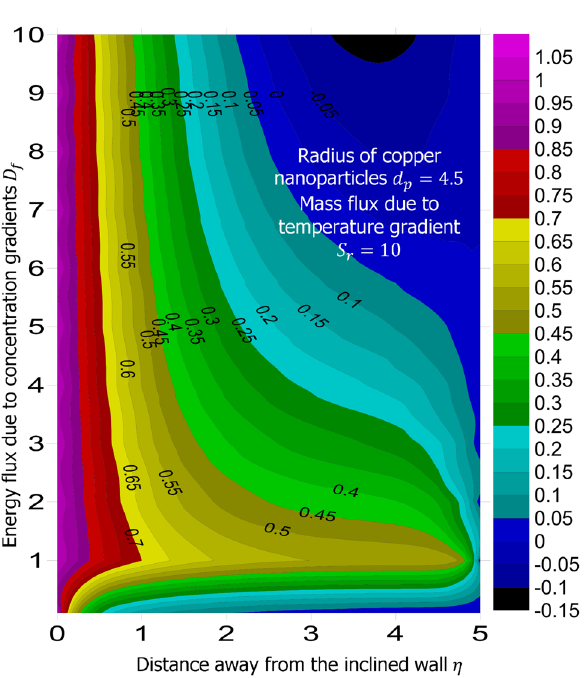
Figure 6. Variation in the distribution of temperature within the domain due to d p at various values of d f